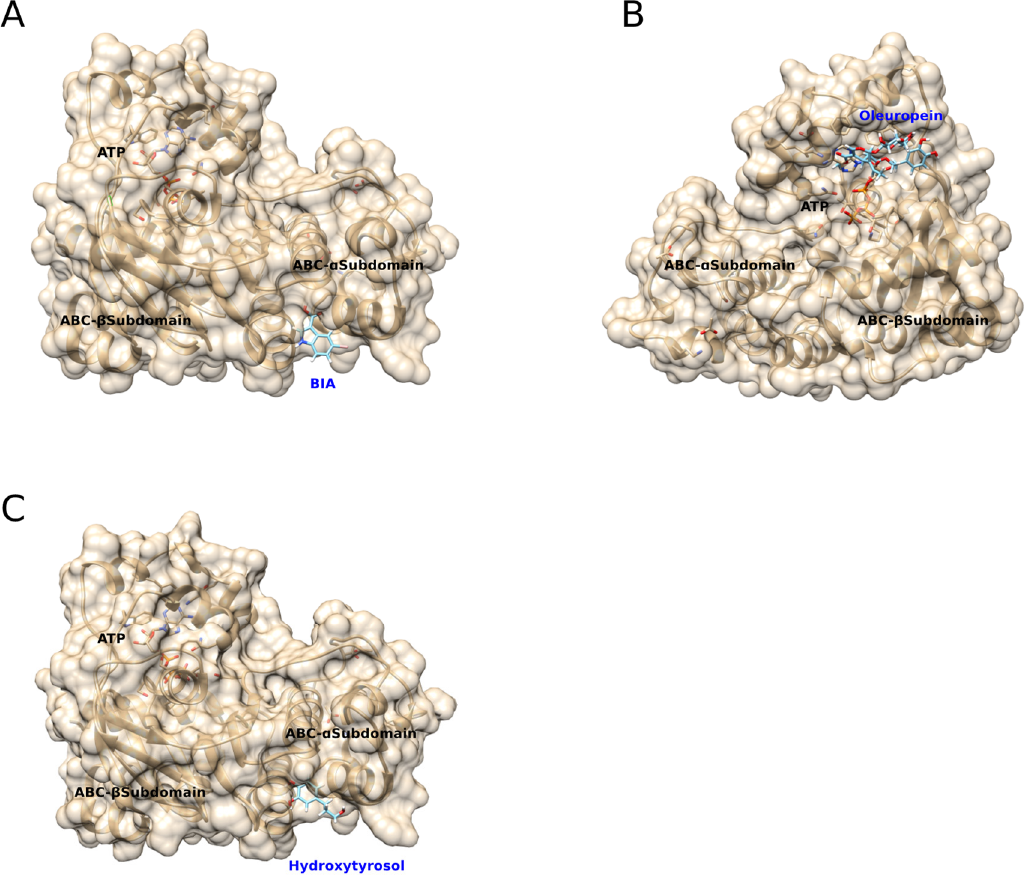
Figure 3. Predicted Binding of BIA, Oleuropein, and Hydroxytyrosol to mNBD1- ∆ F508. SwissDock was used to predict binding modes between BIA ( A ) Oleuropein ( B ) and Hydroxytyrosol ( C ) with mNBD1- ∆ F508 (PDB:3SI7). Docking results for the highest scored complexes for BIA, Oleuropein, and Hydroxytyrosol are shown (see Materials and Methods).